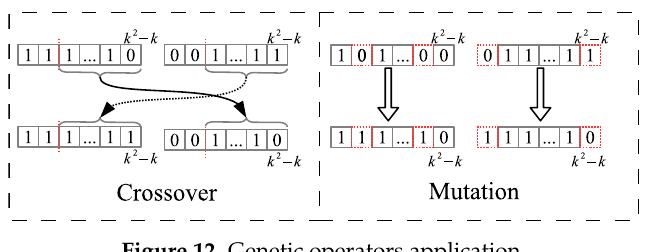
Figure 12. Genetic operators